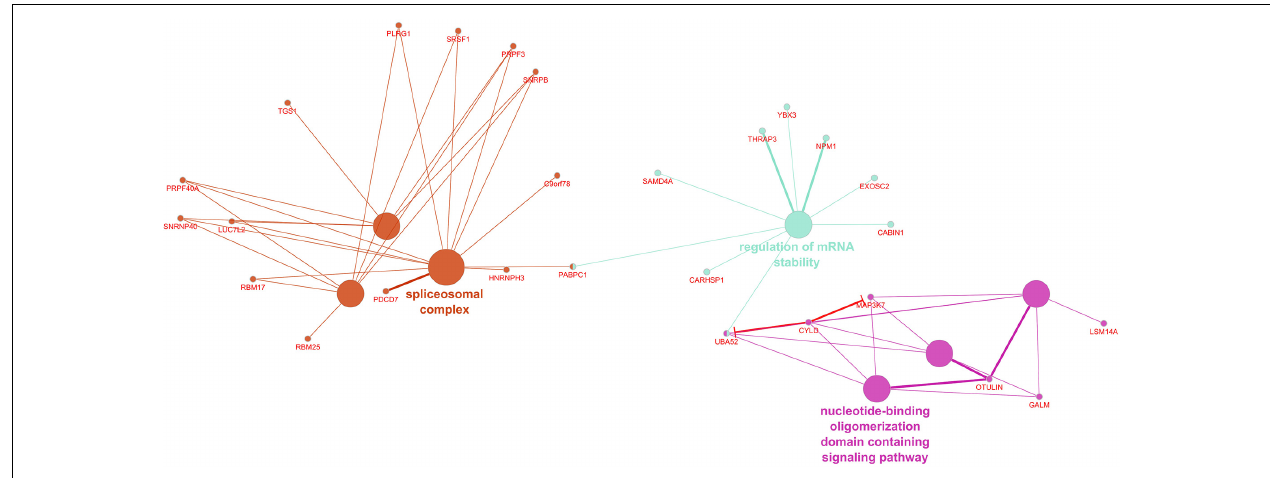
FIGURE 2 | Enriched ClueGO gene network from the interventricular septum. Similar gene ontology or KEGG pathway terms are clustered by color and the representative term for those clusters are presented. Gene names shown in red; Red lines with bars represent interactions involved in gene repression.